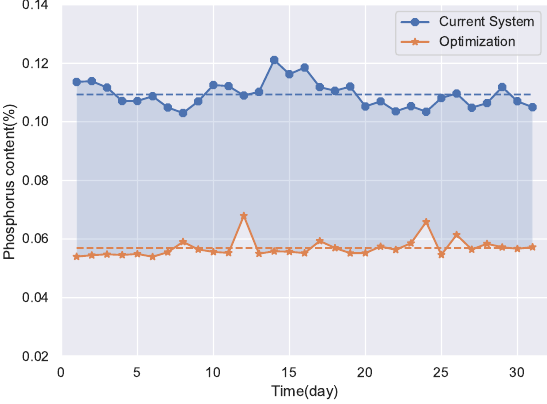
Figure 13. Optimization results of the conventional method. The shaded area in Figure 14 represents the distribution of the uncontrollable